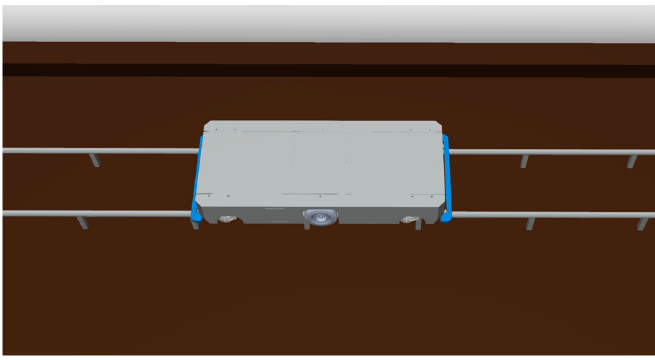
Figure 3. A mobile robot that moves along smart farm rails and passageways.